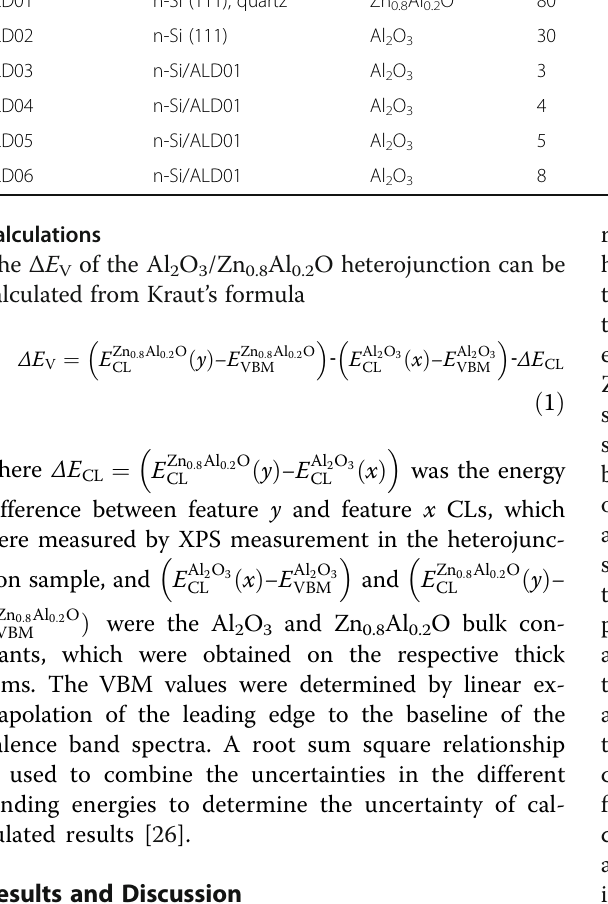
Table 1 Detailed parameters for Zn 0.8 Al 0.2 O and Al 2 O 3 layers Sample no.